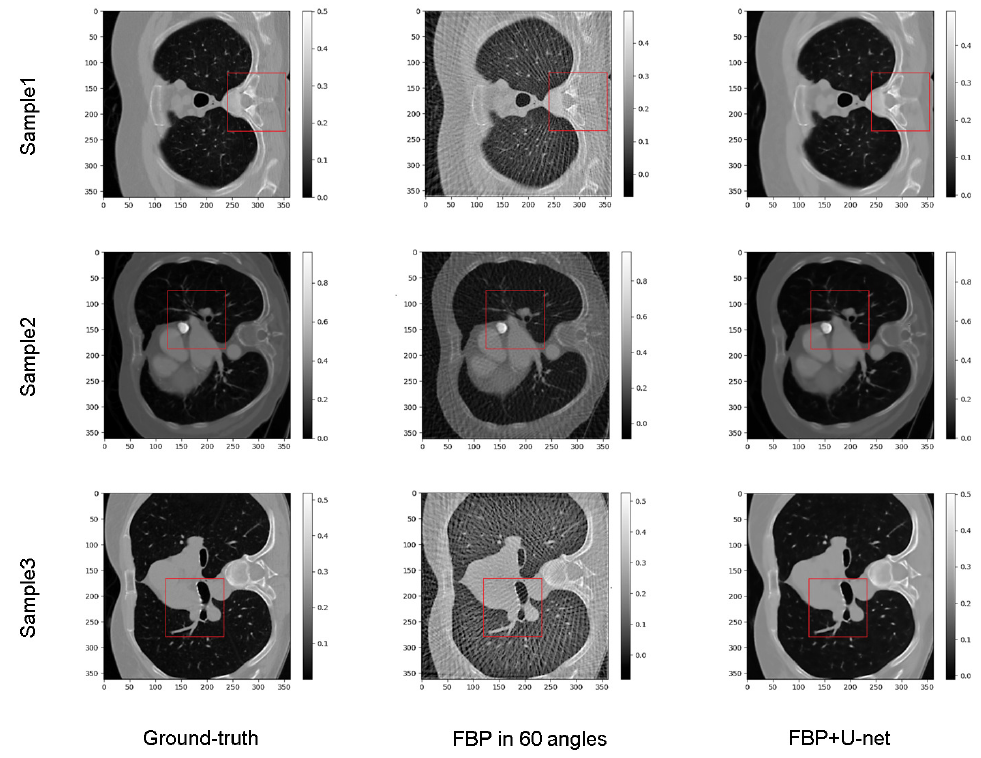
Figure 10. Dataset sample reconstruction.